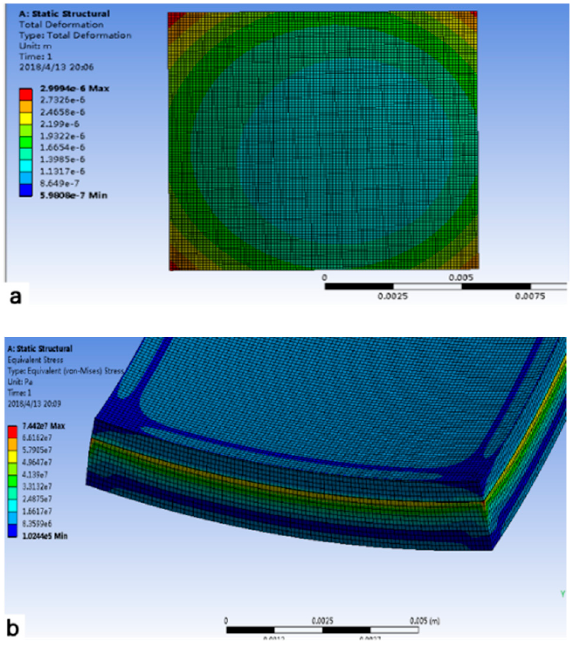
Figure 5. Stress distribution of the model during free expansion: ( a ) stress distribution at the bottom; ( b ) stress distribution on the sidewall.